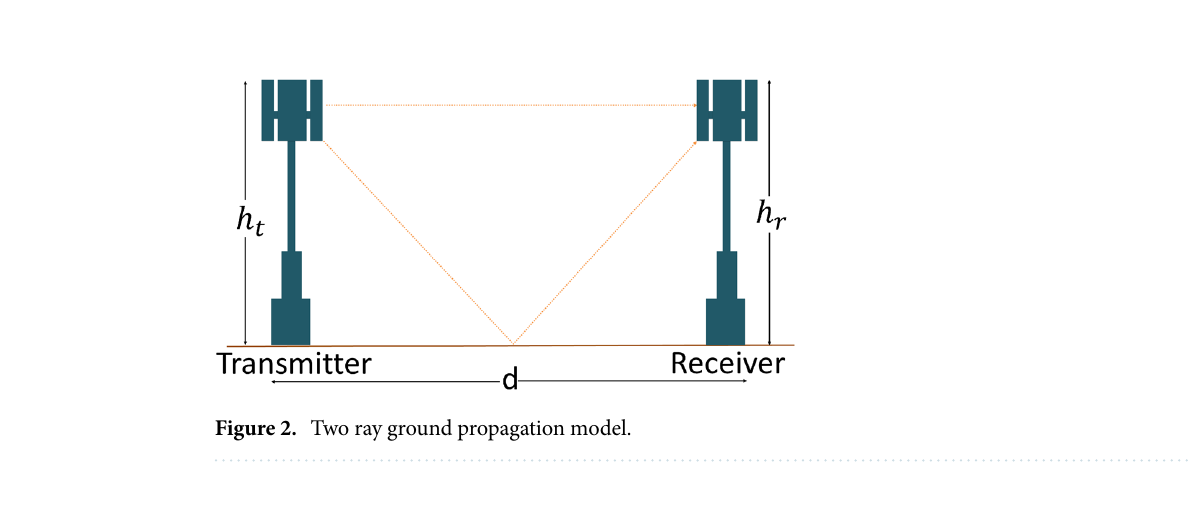
Table 1. A summary of the comparison of the proposed approach with others related works.